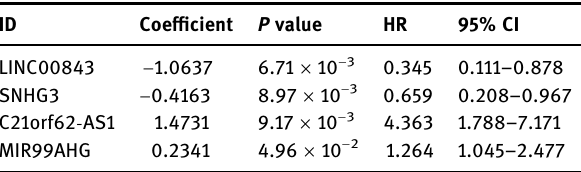
Table 1: Characteristics of four independent prognostic